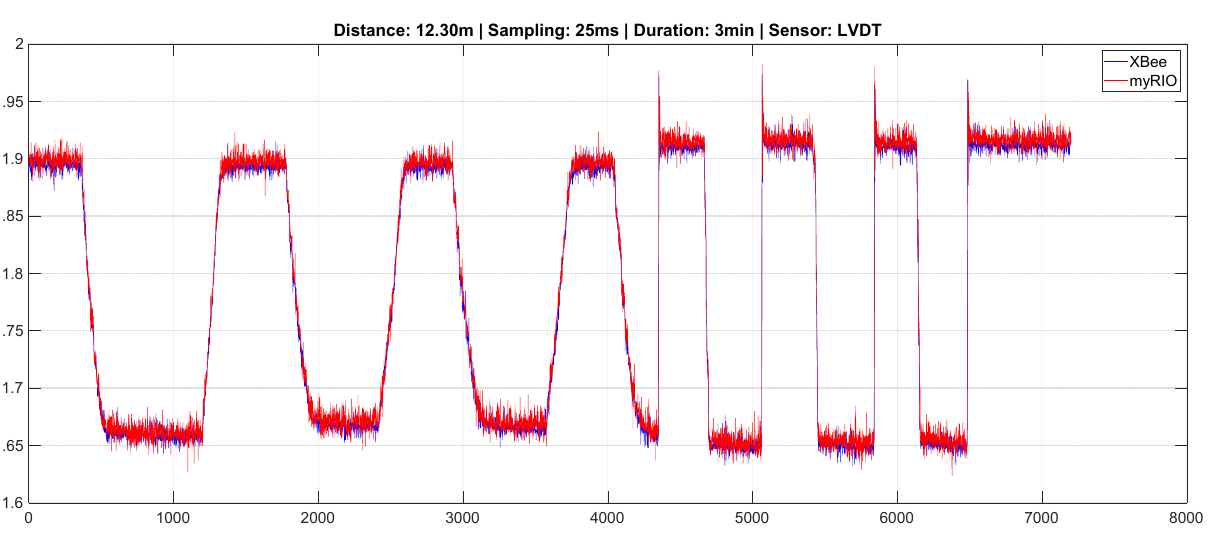
Figure 15. Comparison values acquired with sensors located at the bar-knot structure when a force is applied. Frequency: 40 Hz; Measuring/acquisition separation: 12.30 m. Test duration 3 min. LVDT sensor. Wireless values shown in blue and wired values in red.